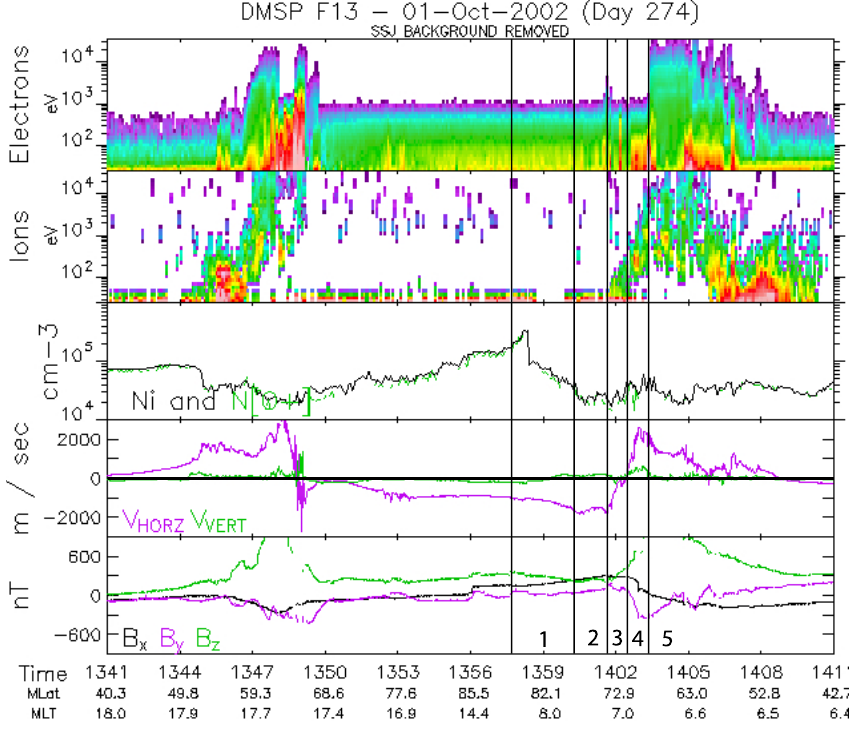
Fig. 7. Northern Hemisphere DMSP F13 data for the interval 13:41–14:11UT. Cross track ion drift (panel 4) is shown in the context of particle precipitation (panels 1 and 2) and Birkeland current regimes ( B z trace in bottom panel). Precipitation/Birkeland current/convection regimes marked by vertical guidelines are: (1): P.RAIN and C1; (2): P.RAIN and flow channel FC 2; (3): C2 current, (4): R1 current; and (5): R2 current. Event category: NH-dawn/ B y > 0 (sunlit). Same format as in Fig.